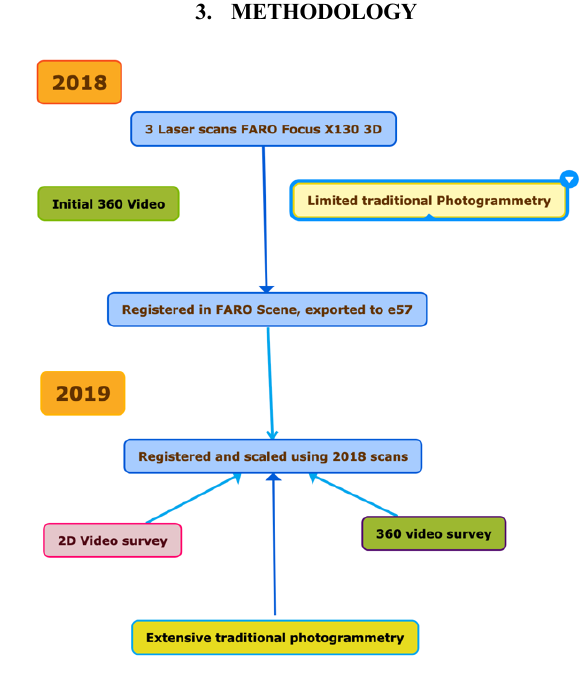
Figure 8. Flowchart and timeline of 3d data acquisition The flow chart (Figure 8) indicates how the initial three laser scans (Two at the east end and one at the west end, made in 2018 were subsequently used to scale the pointclouds from all traditional photogrammetry and spherical